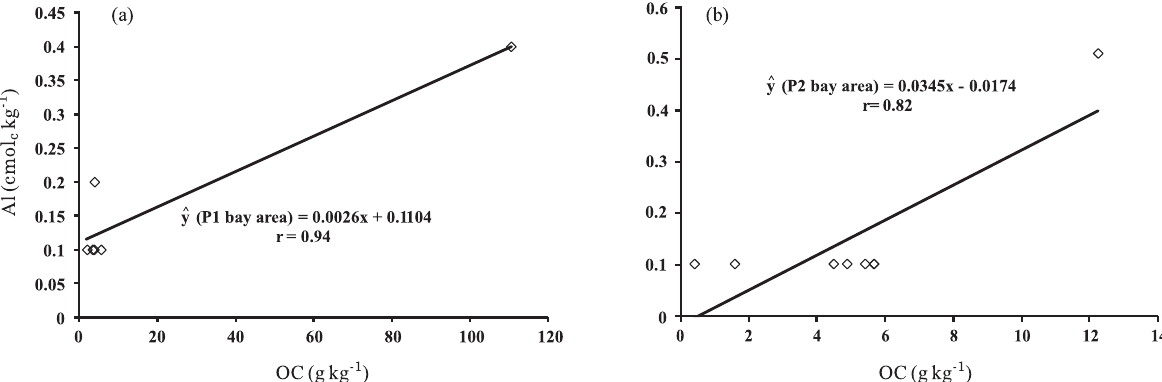
figure 2. Pearson correlation between carbon and aluminium. a: bay profile P1 (p = 0.0023); B: bay profile P2 (p =